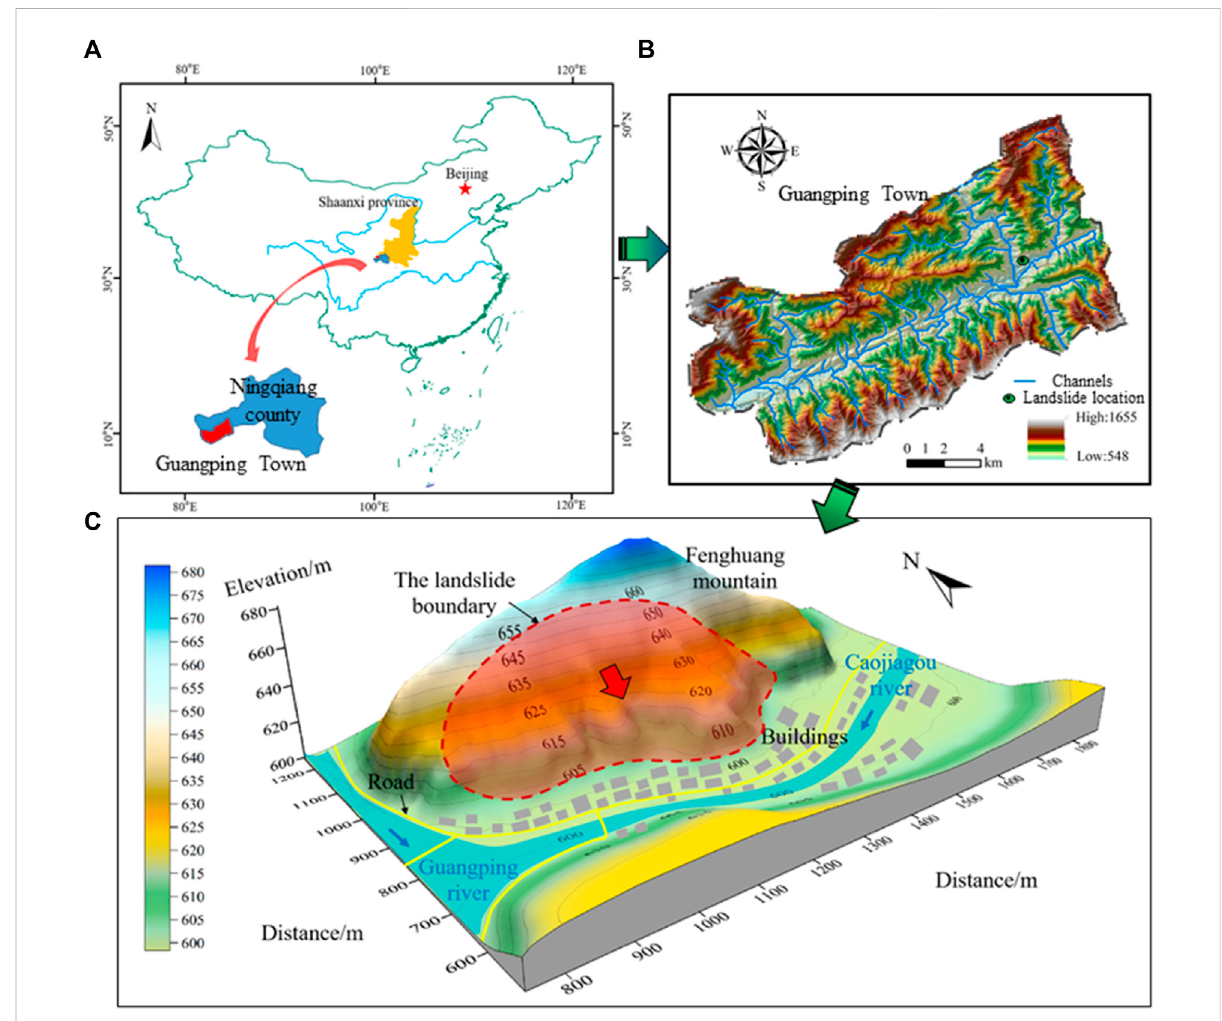
FIGURE 1 Location of Fenghuang Street landslide: (A) the location of Guangping town in China; (B) the elevation distribution of Guangping Town and the location of Fenghuang Street landslide; (C) three-dimensional image of Fenghuang Street